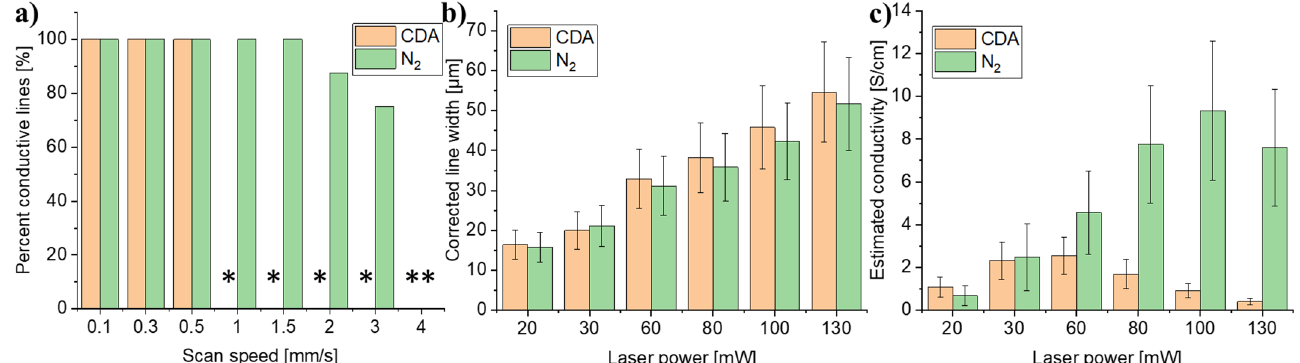
Figure 7. ( a ) Percentage of conductive lines ( n ≥ 4), ( b ) corrected line width, and ( c ) estimated conductivity of lines written under different gas-purge conditions. Lines written at ( a ) 80 mW power and ( b , c ) 0.5 mm/s scan speed, respectively. The asterisks (*) indicate that no conductive lines were obtained at these settings. All error bars are the standard deviations ( n = 4).